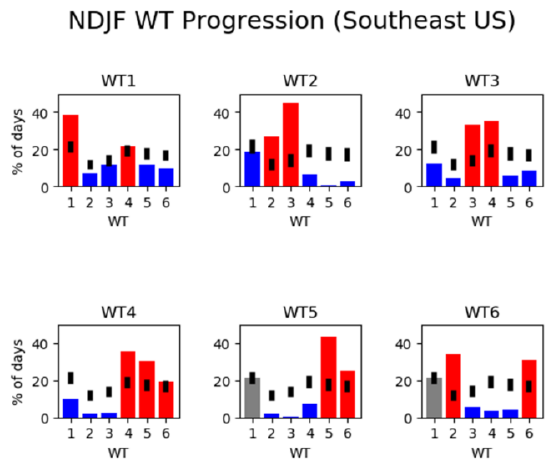
Figure 6. The progression of the WTs. The 95% confidence interval of the WT background frequency (the occurrence of WT transition due to chance) is shown with black shading. Frequencies significantly greater than the background frequency are shown with red bars; frequencies significantly less than the background bars are shown with blue